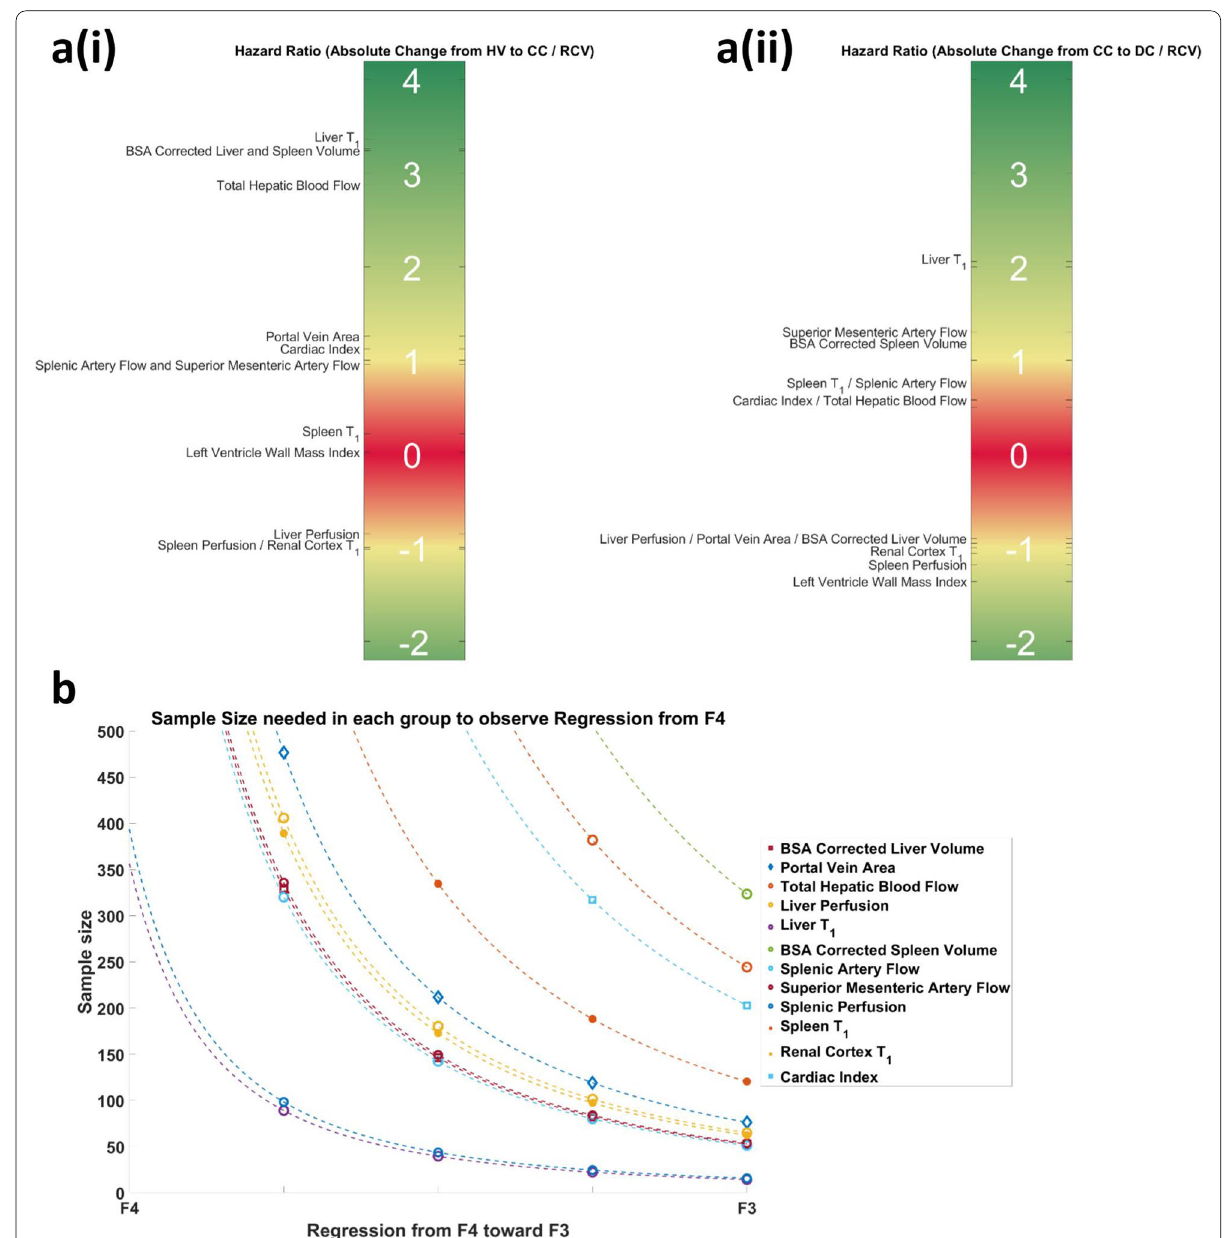
Fig. 7 A schematic of the hazard ratio (HR) for disease progression. Panel a (i) shows the progression from healthy volunteer (HV) to compensated cirrhosis (CC), whilst panel a (ii) shows that the hazard ratio for progression from CC to decompensated cirrhosis (DC). Positive values indicate an increase in measure and negative values a decrease in measures. If the absolute value of the HR is >1 this indicates the reference change value (RCV) is less than the clinical change. Panel b shows sample size estimation for the number of CC patients required in clinical trial to detect a change from stage F4 (compensated cirrhosis, CC) to F3 (advanced cirrhosis) liver disease which has clinical significance; data points are shown for a 25%, 50%, 75%, and 100% regression from F4 to F3. BSA Body surface